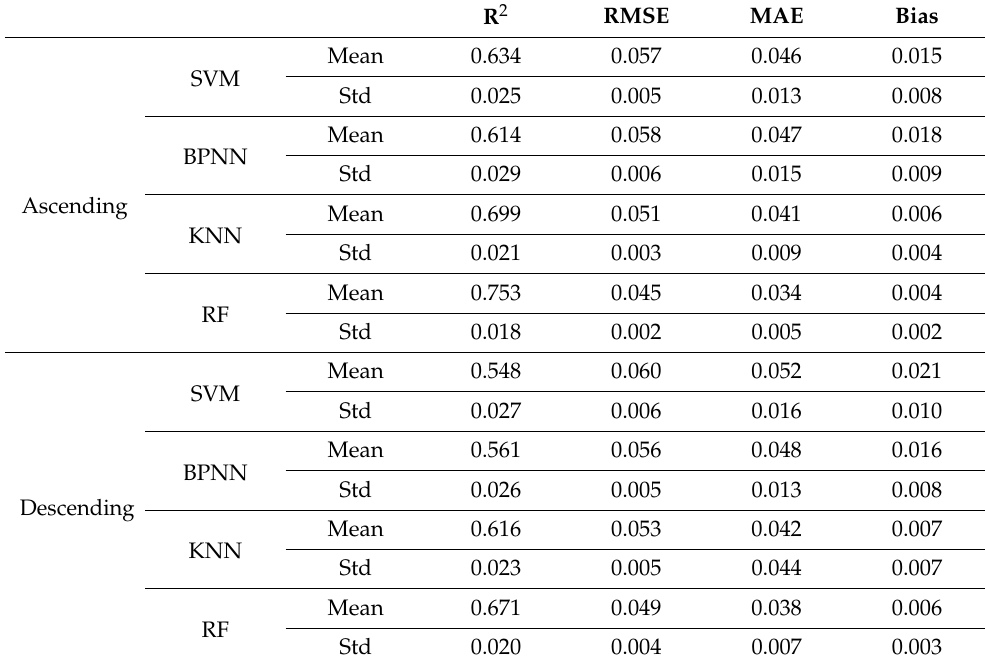
Table 1. Training accuracies of the different machine learning